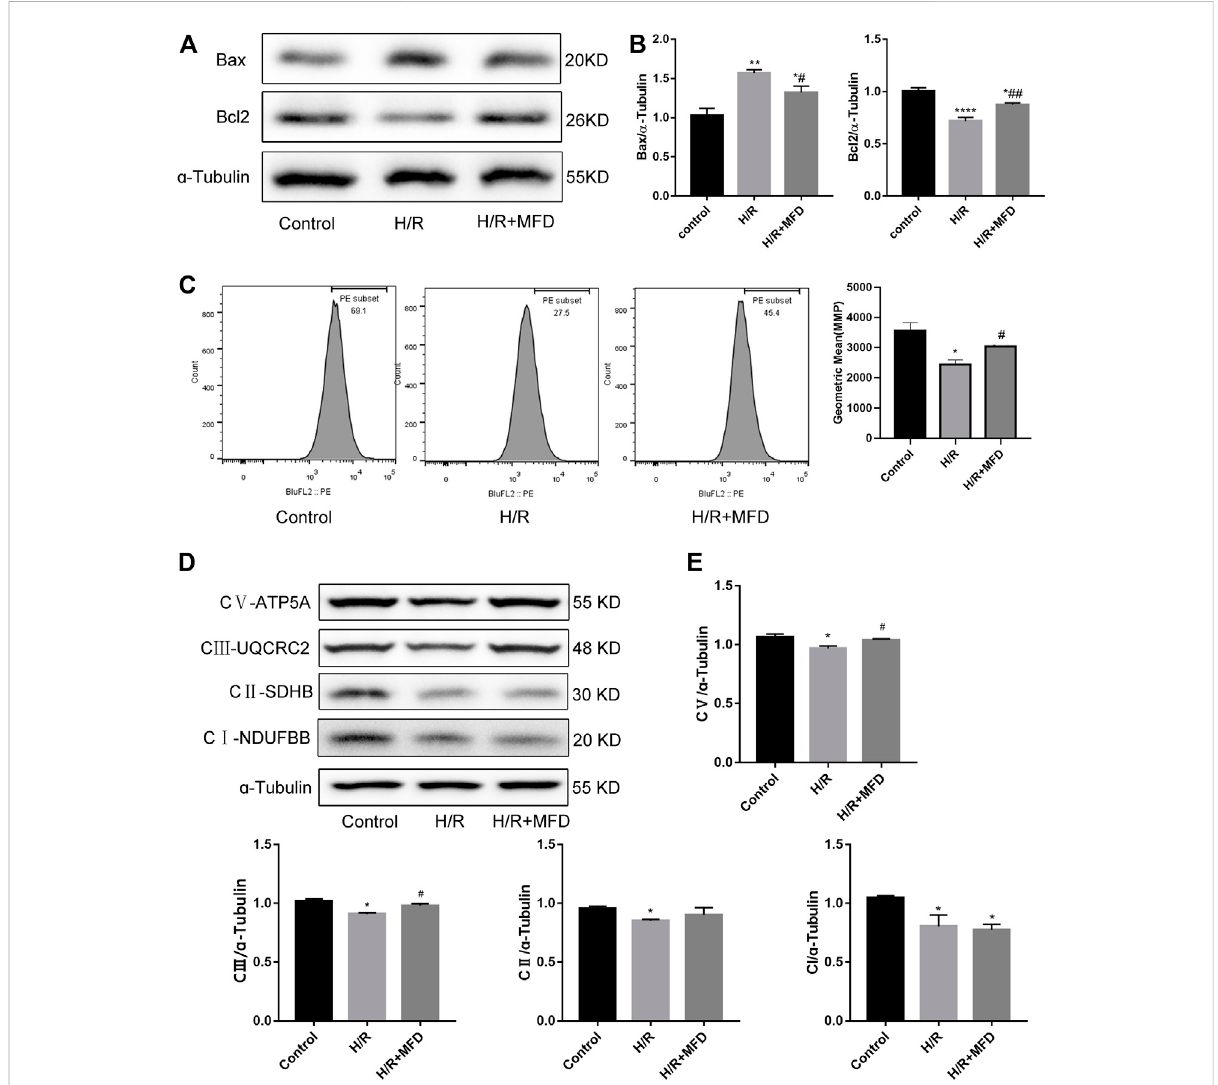
Mefunidone reduced H/R-induced mitochondrial damage and complex Ⅲ and Ⅴ of mitochondrial electron transport chain complex in HK-2 cells (A,B) Westernblotanalysisandquantitativedataofbaxandbcl2intheH/RmodelofHK-2cellswithorwithoutmefunidone. (C) Flowcytometry and quantitative comparison were applied to test MMP of HK-2 cells in the H/R model of HK-2 cells with or without mefunidone. (D,E) Western blot analysis and quantitative data of mitochondrial electron transport chain complex in the H/R model of HK-2 cells with or without